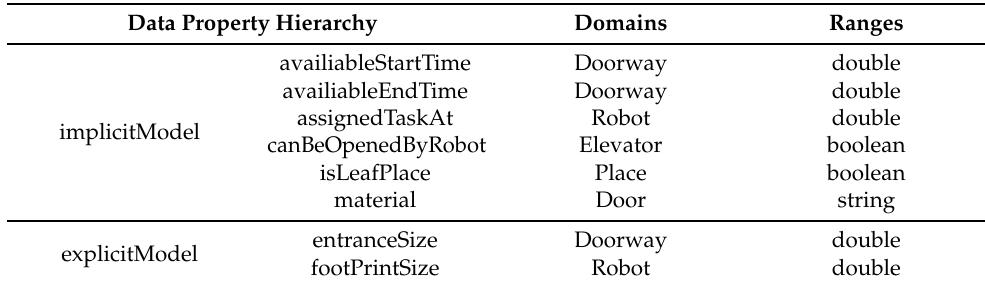
Table 2. Data properties for EnvironmentalElement